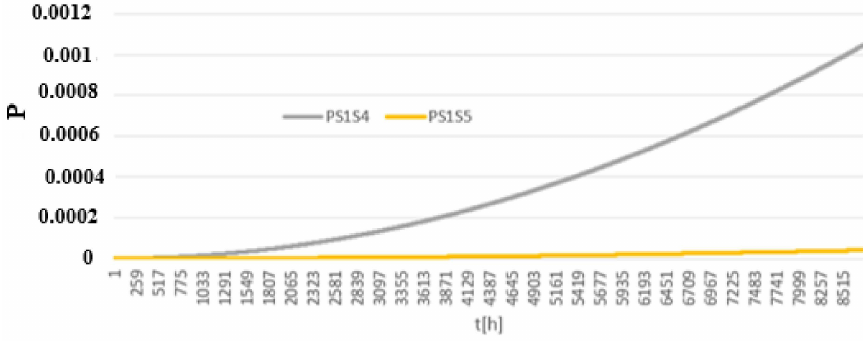
Figure 10. Probability of FAS transitioning from state S1 to states S4 and S5.